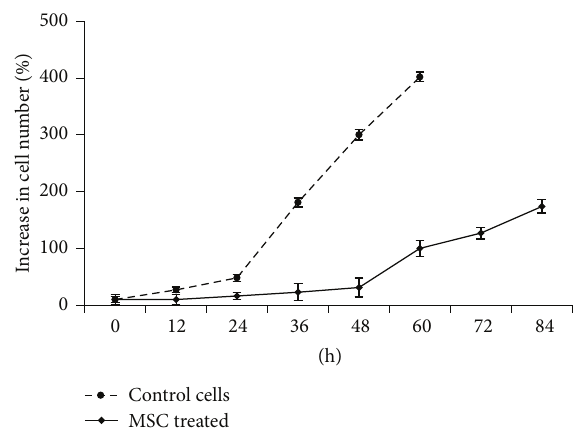
Figure 2: The results of cell count analyses of HEK 293T cells grown in the absence (control cells) or presence of apoptotic MSCs (MSC- treated) [35]. The analyses suggest that there was decreased growth of the MSC-treated cells during 0–48 hours of cytoplasmic material transfer from the MSCs to HEK 293T